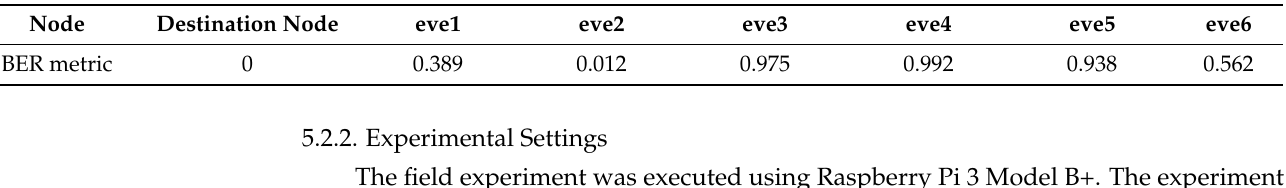
Table 5. Results of friendly jamming (field